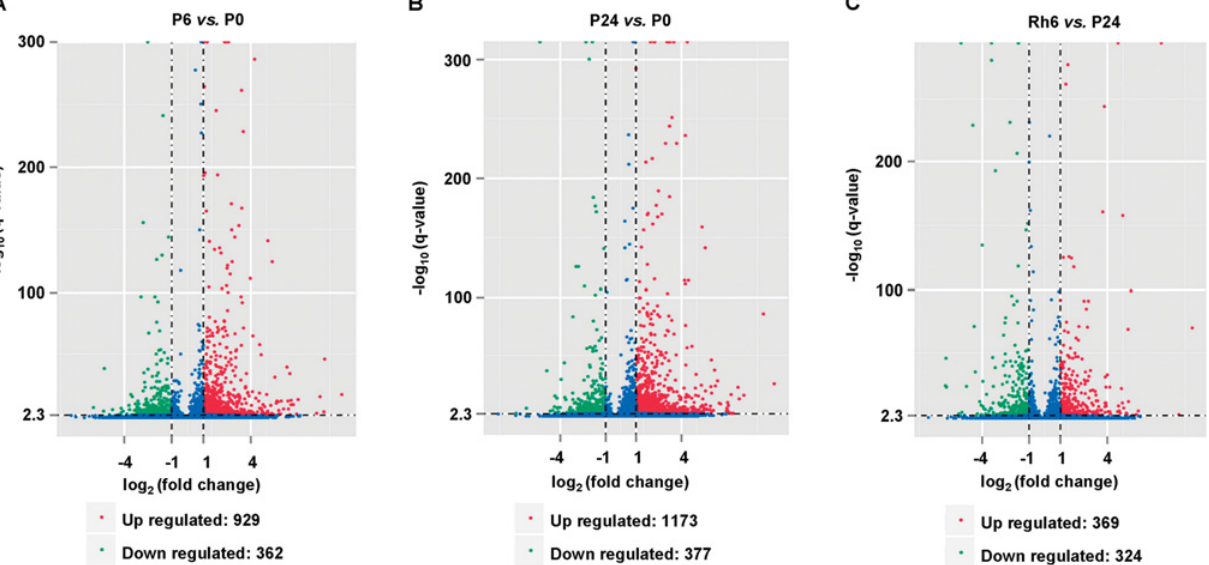
Fig 7. Gene expression profile changes in the A . sparsifolia primary roots during 24h of PEG treatment following 6h of rehydration. Comparisons between P6 and P0 (A), P24 and P0 (B), and Rh6 and P24 (C) were made on the basis of q -value < 0.005 and |log2(foldchange)| > 1. P0 represents the untreated primary roots. P6 and P24 represent the primary roots with 6h and 24h of PEG treatment, respectively. Rh6 represents the primary roots with 6h of rehydration preceded by 24h of PEG treatment. The identified up- and down-regulated genes are denoted as the red and green dots, and their numbers of are